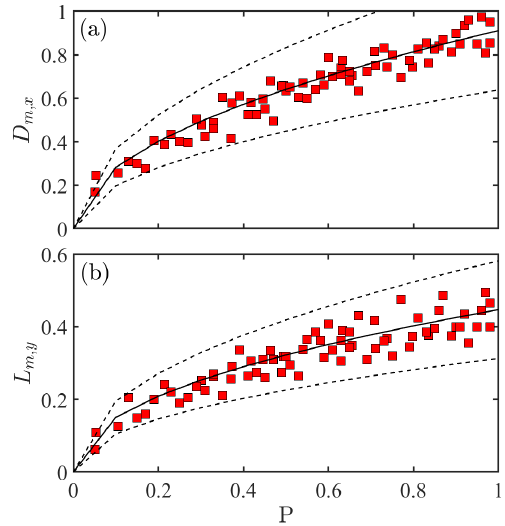
Figure 12. Variation of ( a ) D m , x and ( b ) L m , y with P, for all experiments. The solid line and the dashed lines denote the fitting curve and the ± 30% derivation range,